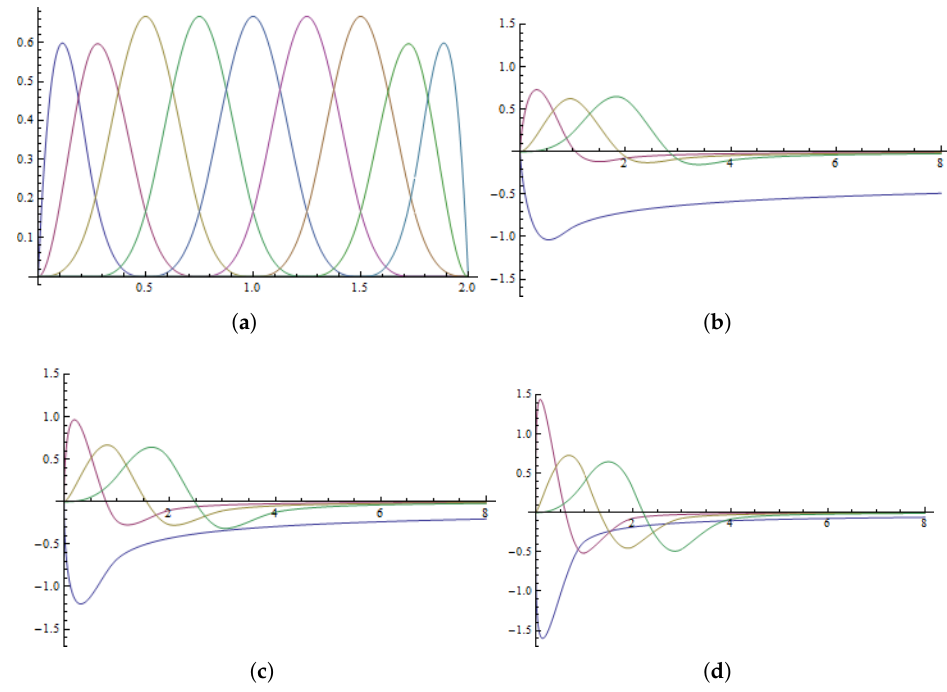
Figure 1. ( a ) the optimal B-spline basis N 3 in the interval [ 0,2 ] for h = 0.25; ( b – d ) the fractional N 03 (blue), C D β N 13 (purple), C D β N 23 (dark yellow), C D β derivatives C D β t t t β = 0.25 ( b ), β = 0.5 ( c ), β = 0.75 ( d ).